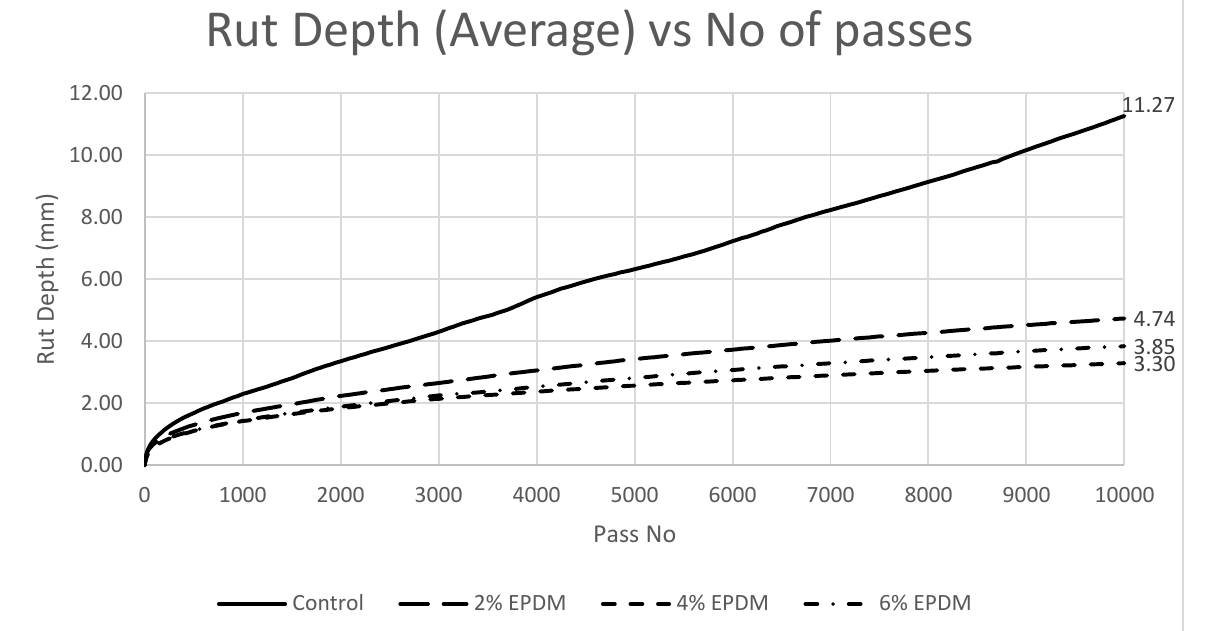
Figure 7. Initial flexural stiffness results.